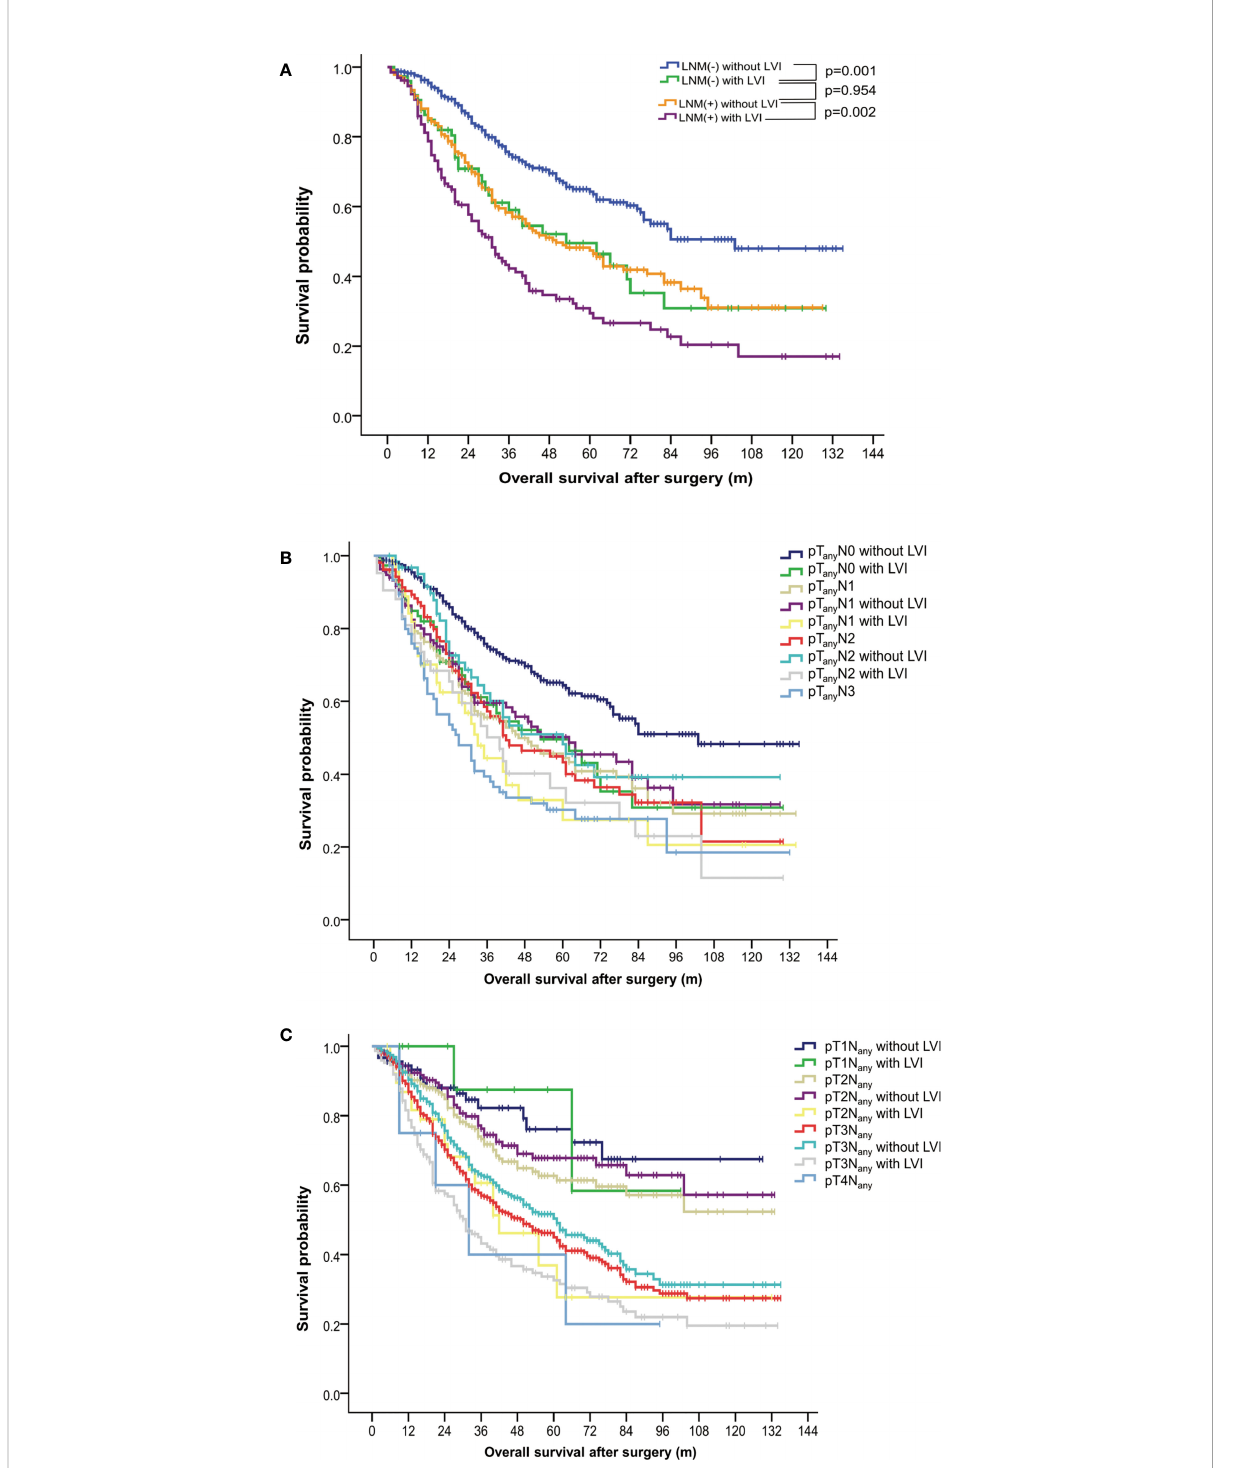
FIGURE 2 Subgroup analysis of overall survival in patients with esophageal squamous cell carcinoma. (A) Survival curves strati fi ed by status of lymphovascular invasion and lymph node metastasis. (B) Survival curves strati fi ed by status of lymphovascular invasion and pathological N classi fi cations. (C) Survival curves strati fi ed by status of lymphovascular invasion and pathological T classi fi cations. LNM, lymph node metastasis; LVI, lymphovascular